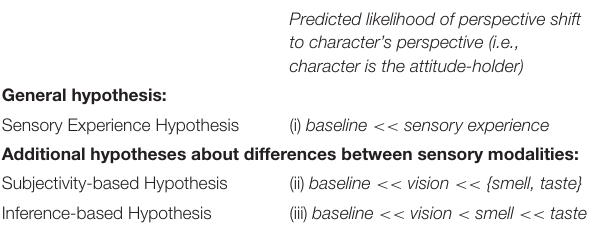
TABLE 2 | Predictions of the three